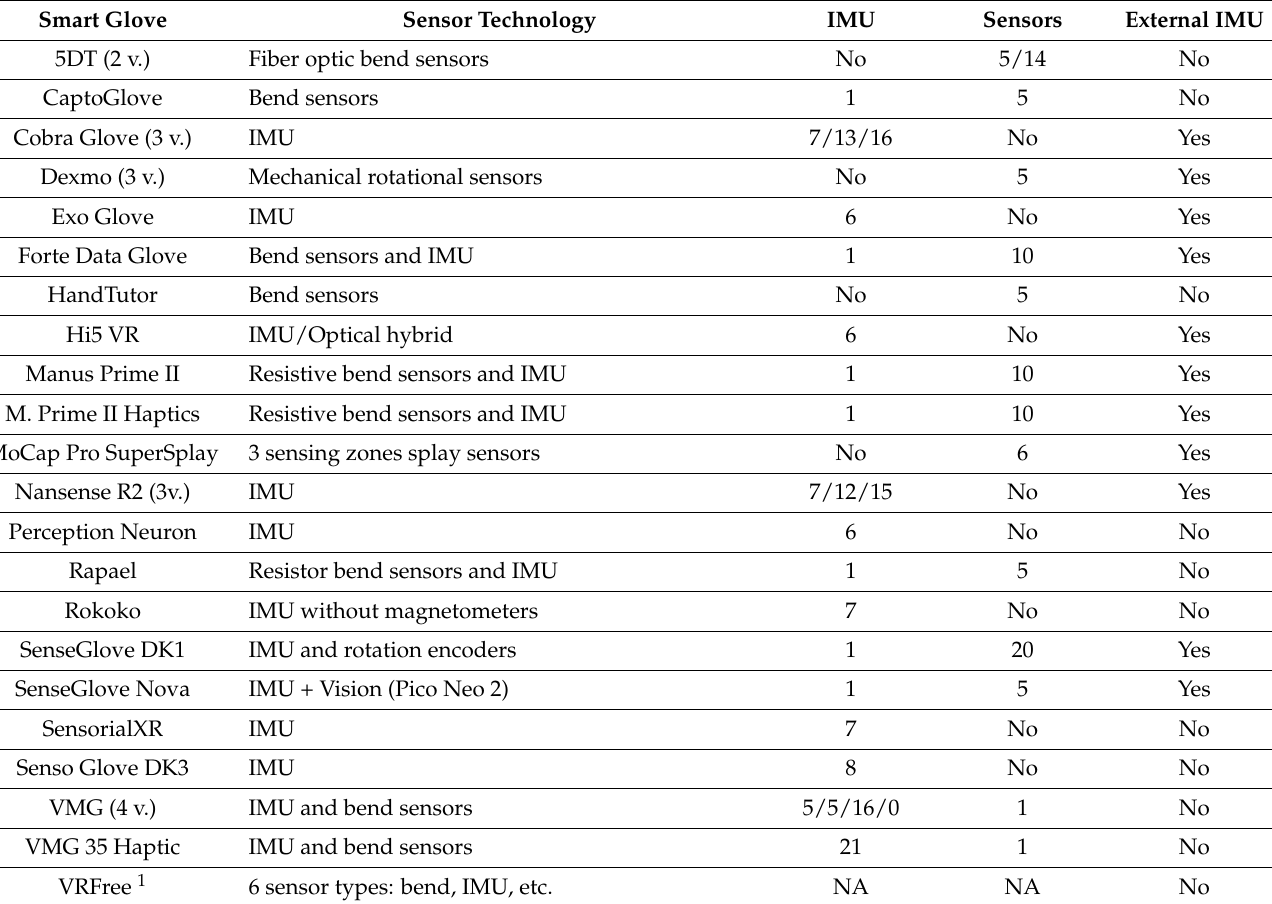
Table 4. Commercial smart gloves for hand and finger pose estimation and motion tracking. Smart